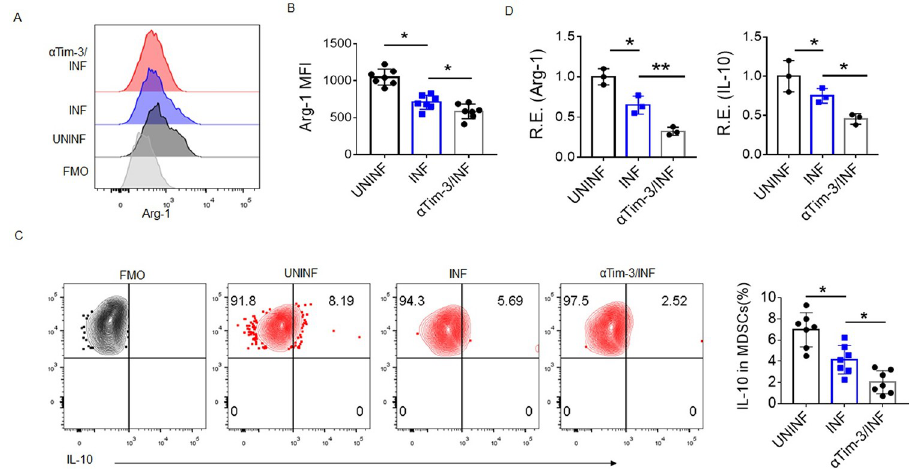
Fig 3. The blockage of Tim-3 by a neutralizing antibody impedes human decidual MDSCs activation during T . gondii infection. (A–B) Representative flow cytometry results (A) and statistical analysis (B) of Arg-1 expression in human decidual MDSCs from groups of normal control (UNINF), T . gondii infection (INF), and Tim-3 neutralizing antibody ( α Tim-3) treatment plus T . gondii infection ( α Tim-3/INF) (data represent the mean ± SD from 7 human samples). (C) Representative flow cytometry results and statistical analysis of the intracellular level of IL-10 in human decidual MDSCs in the UNINF, INF, and α Tim-3/INF groups (data represent the mean ± SDs from 7 human samples). Cells from UNINF group were used for the FMO conditions. (D) qPCR was used to analyze the expression of Arg-1 and IL-10 in the infected human decidual MDSCs after α Tim-3 treatment (data represent the mean ± SD from three independent experiments). * p < 0.05, ** p < 0.01, One-way ANOVA.